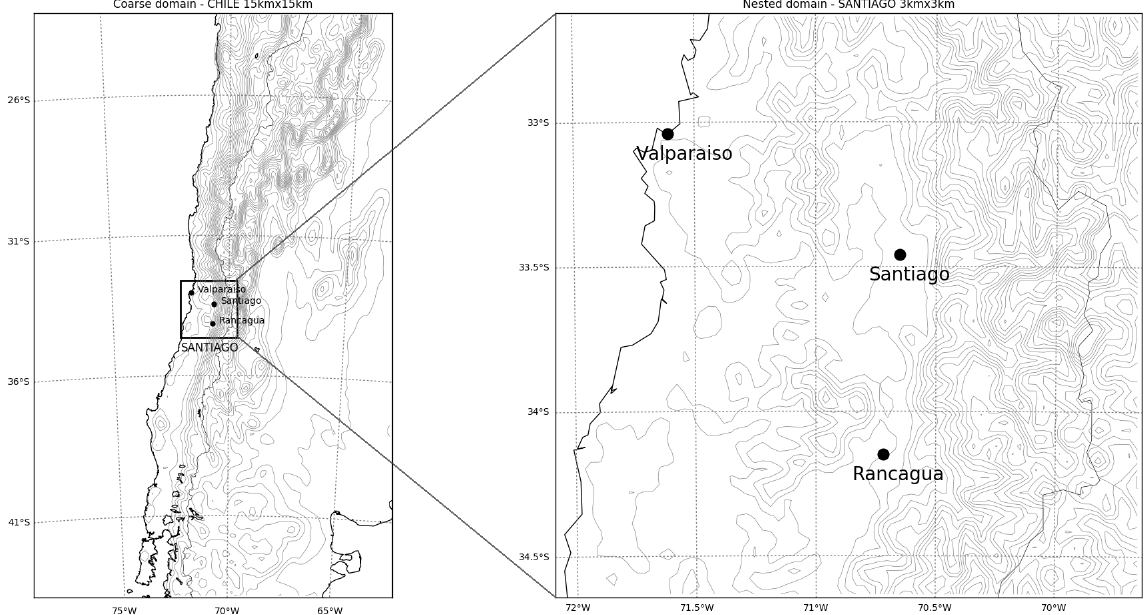
Figure 1. Left panel: coarse simulation domain at a 15km resolution. Right panel: nested domain at a 3km resolution. The 250m contour levels shown are interpolated from the modified IGBP MODIS 20-category database with a 30s resolution (University of Maryland, 2010). Table 1. WRF and CHIMERE configurations.